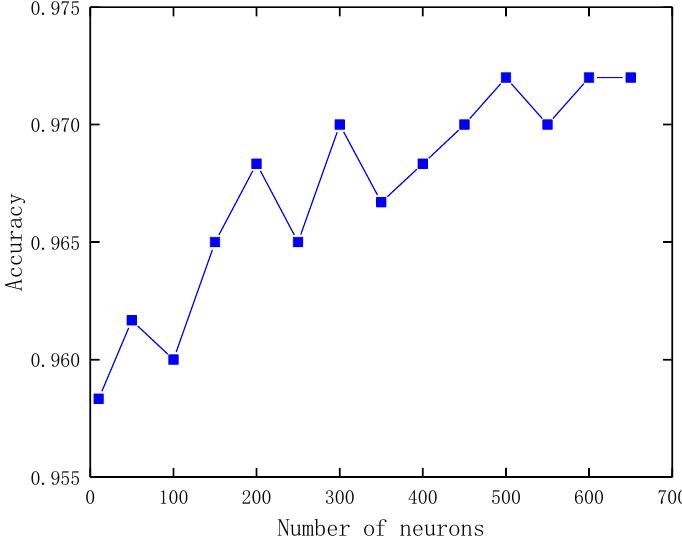
Figure 5. The accuracy variation of CNNs with the number of middle-layer neurons. Table 1. The accuracy variation with the number of middle-layer